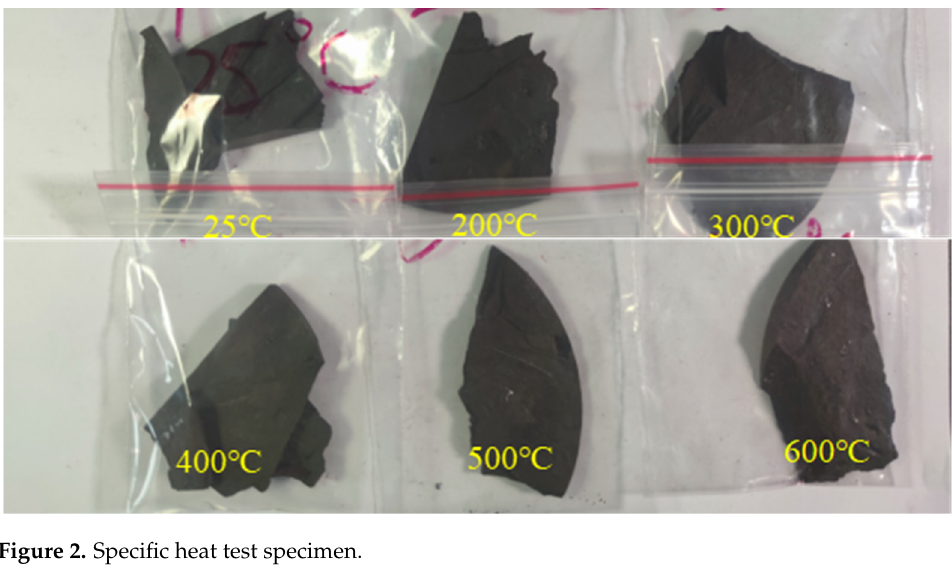
Figure 2. Specific heat test specimen.